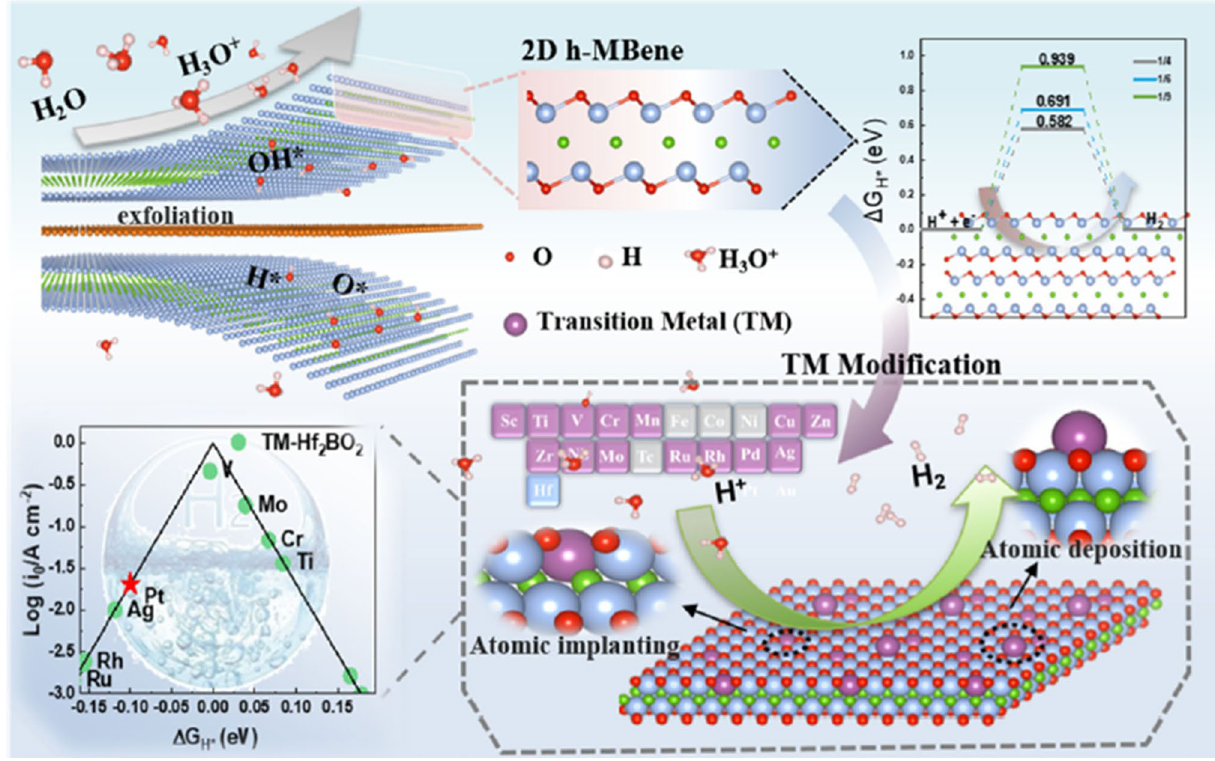
Fig. 16 Schematic illustration of the process of preparing h-MBenes by exfoliating A layer and transition metal (TM) modification approaches by atomic deposition and atomic implanting. Reproduced with permission from Ref.